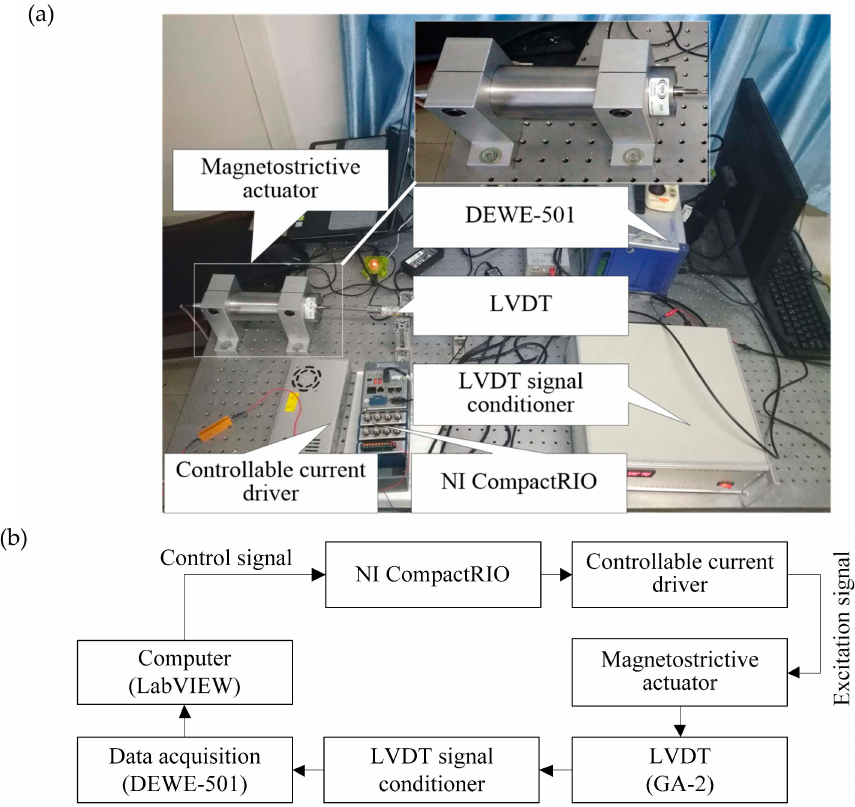
Figure 4. Experimental setup for characteristic tests of the magnetostrictive actuator: ( a ) the photograph and ( b ) the